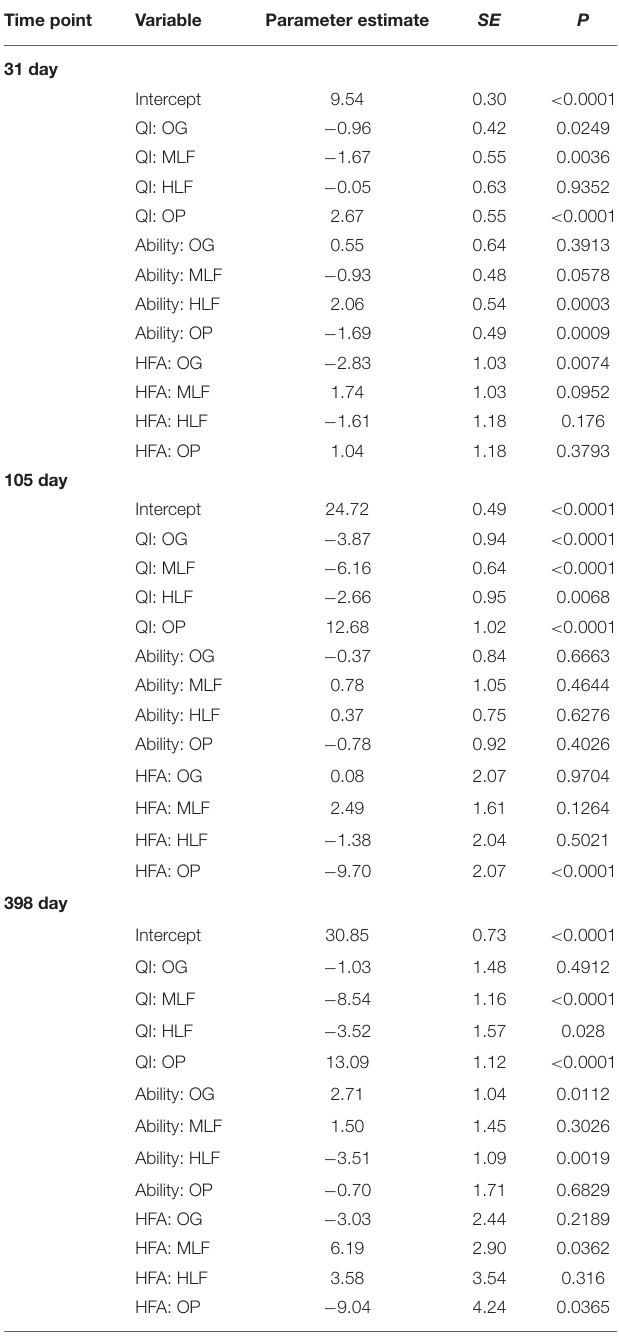
TABLE 6 | Output from the decomposer ability regression test (DART) using mass loss of litter mixtures from old growth (OG) forest, moderate logged (ML) forest, heavily logged (HL) forest, and oil palm after 31, 105, and 398 days as a proxy for